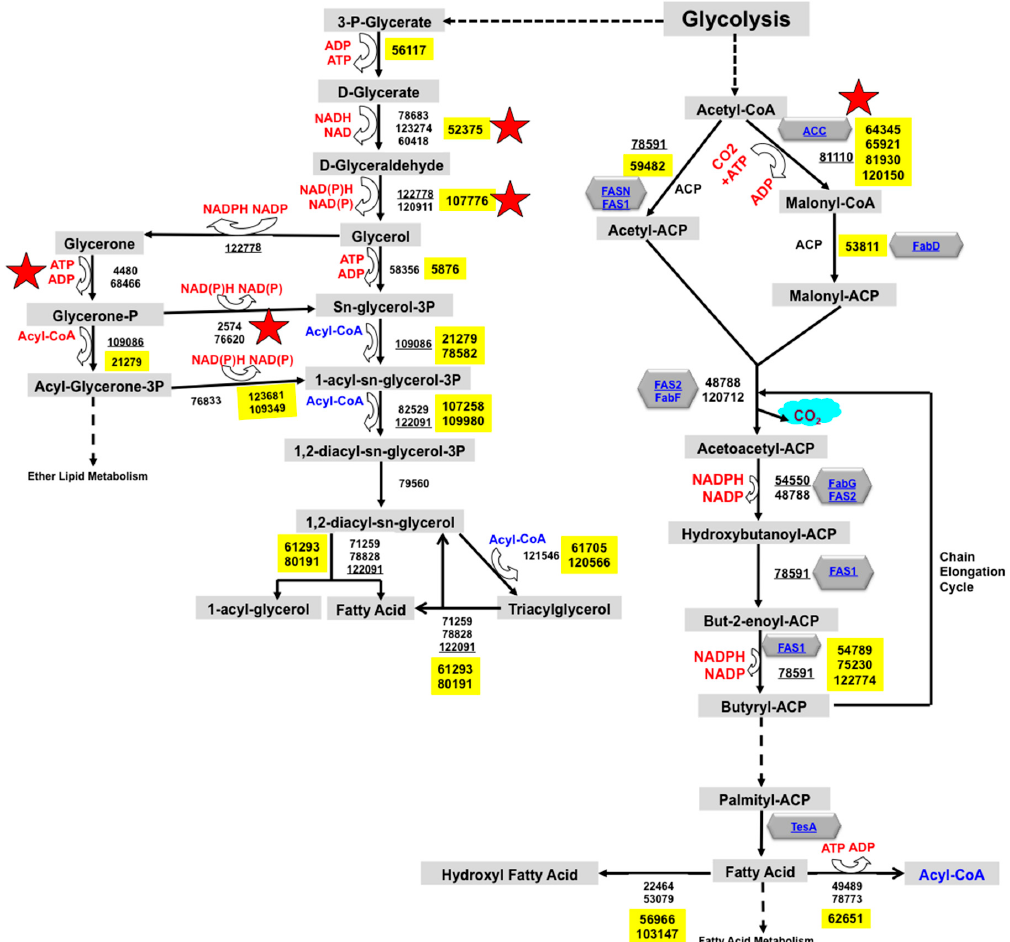
Figure 1. The reconstructed fatty acid metabolism pathway in Trichoderma reesei . Enzymes are represented by gray diamond boxes. The number(s) adjacent to enzyme represent the homologous proteins ID number identified in Trichoderma reesei genome with yellow highlight indicating reasonable similarity to homologous proteins. Multiple numbers were included for enzyme with multiple homologues. Example reactions discussed are marked by a red star.